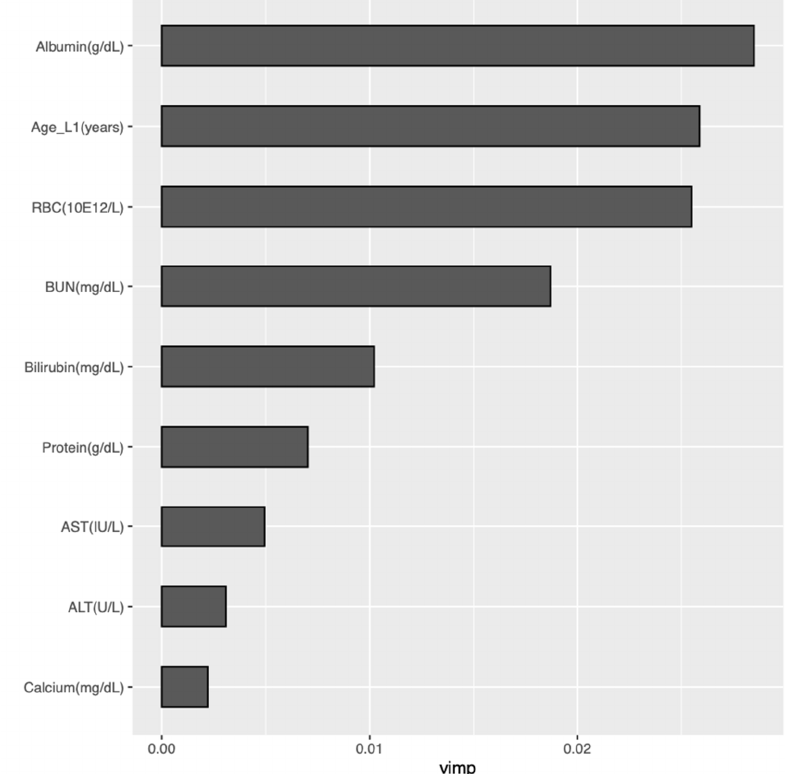
Figure 4. Variable importance plot for RSF analysis of the curated + labs dataset. RSF: random survival forest; L1: time of initiation of first-line therapy; RBC: erythrocytes: BUN: urea nitrogen;